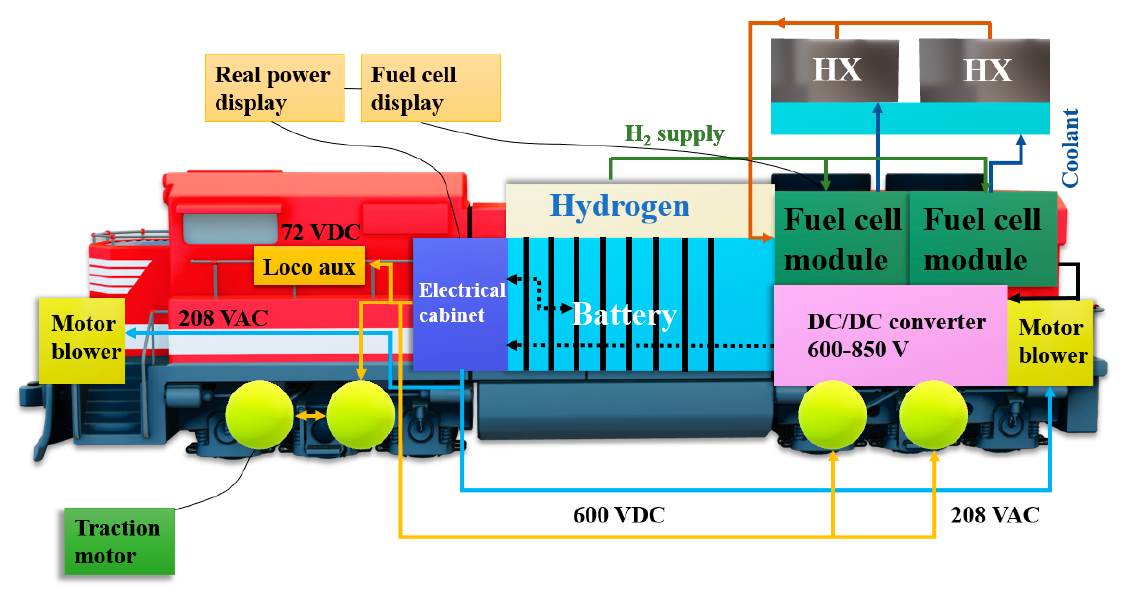
Figure 10. An example of a hybrid locomotive system with fuel cells (HX—heat exchanger; DC—direct current) [31].